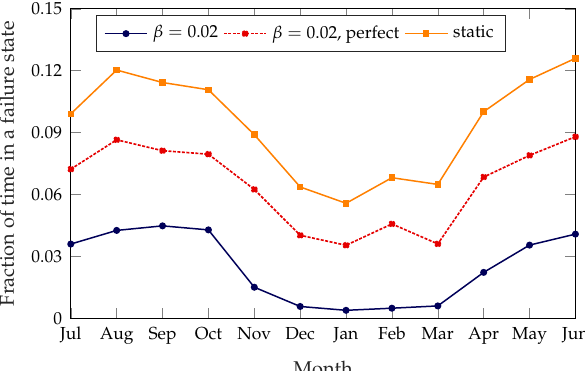
Figure 12. Average fraction of time in a failure state with perfect and imperfect demand information, plotted over 12